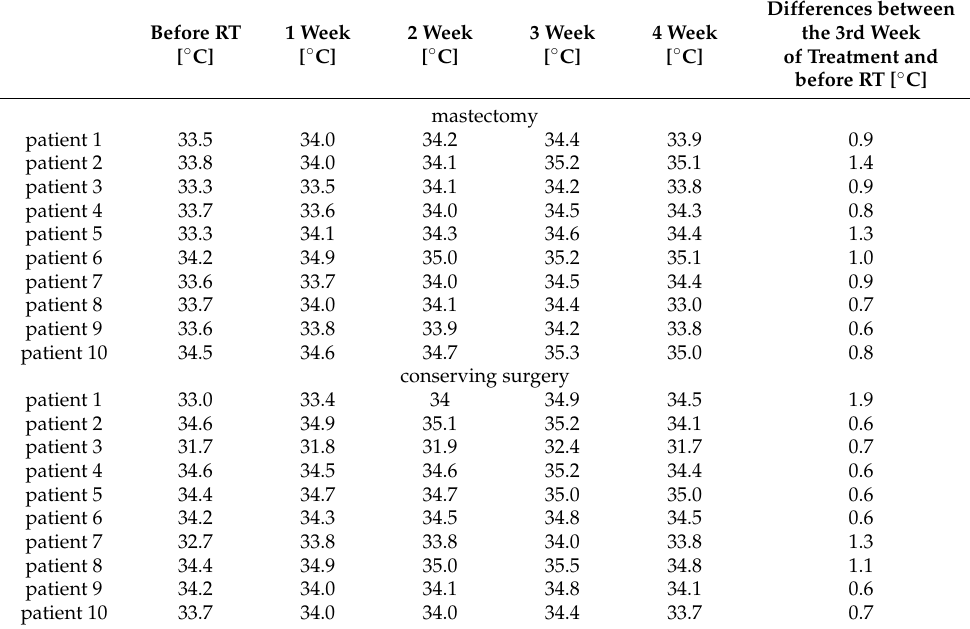
Figure 4. Correlation of temperature changes with the time of radiotherapy digestion for the PTV area and 30 Gy, 20 Gy, and 10 Gy isodoses in 27 patients after conserving surgery. The confidence interval was 0.95. Table 1. Temperature changes in the PTV area shown in 20 exemplary patients. The calculated difference between the 3rd week of treatment and the mean temperature before radiotherapy and the differences between the breast temperature in the healthy